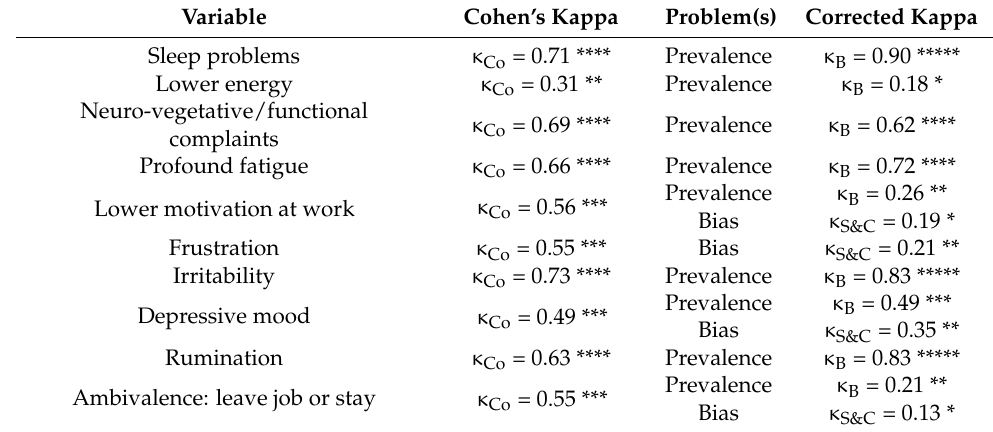
Table 3. Inter-rater reliability of the symptoms identified and the detection reached by the four raters using the